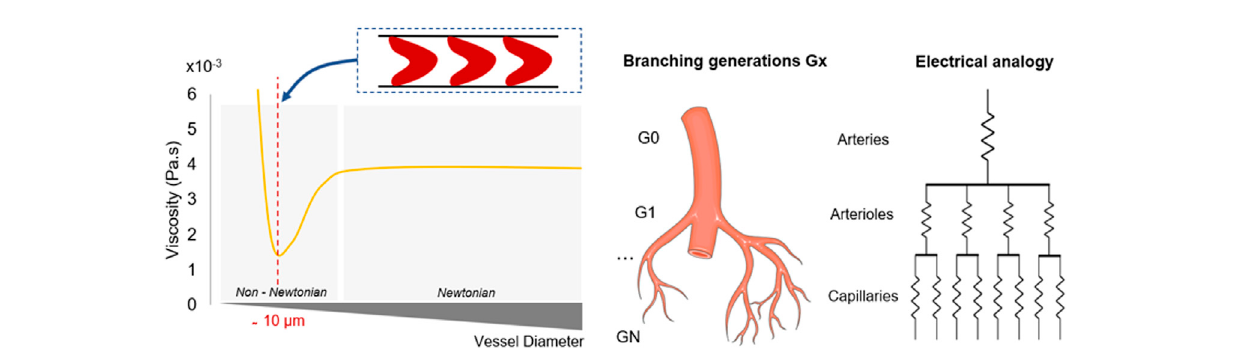
Physicalparametersassociatedwithvesselradiusreduction.Figuresontheleftdetailtherheologicalpropertiesofthebloodregardingtheshrinkage of the vessels throughout the network. Shear forces and non-Newtonian in fl uence increase as the vessel radius decreases. Viscosity reaches a minimum when the vessel diameter equals theRBCs dimension, before experiencing asharpincrease. On the right, the electrical analogy describes the successive